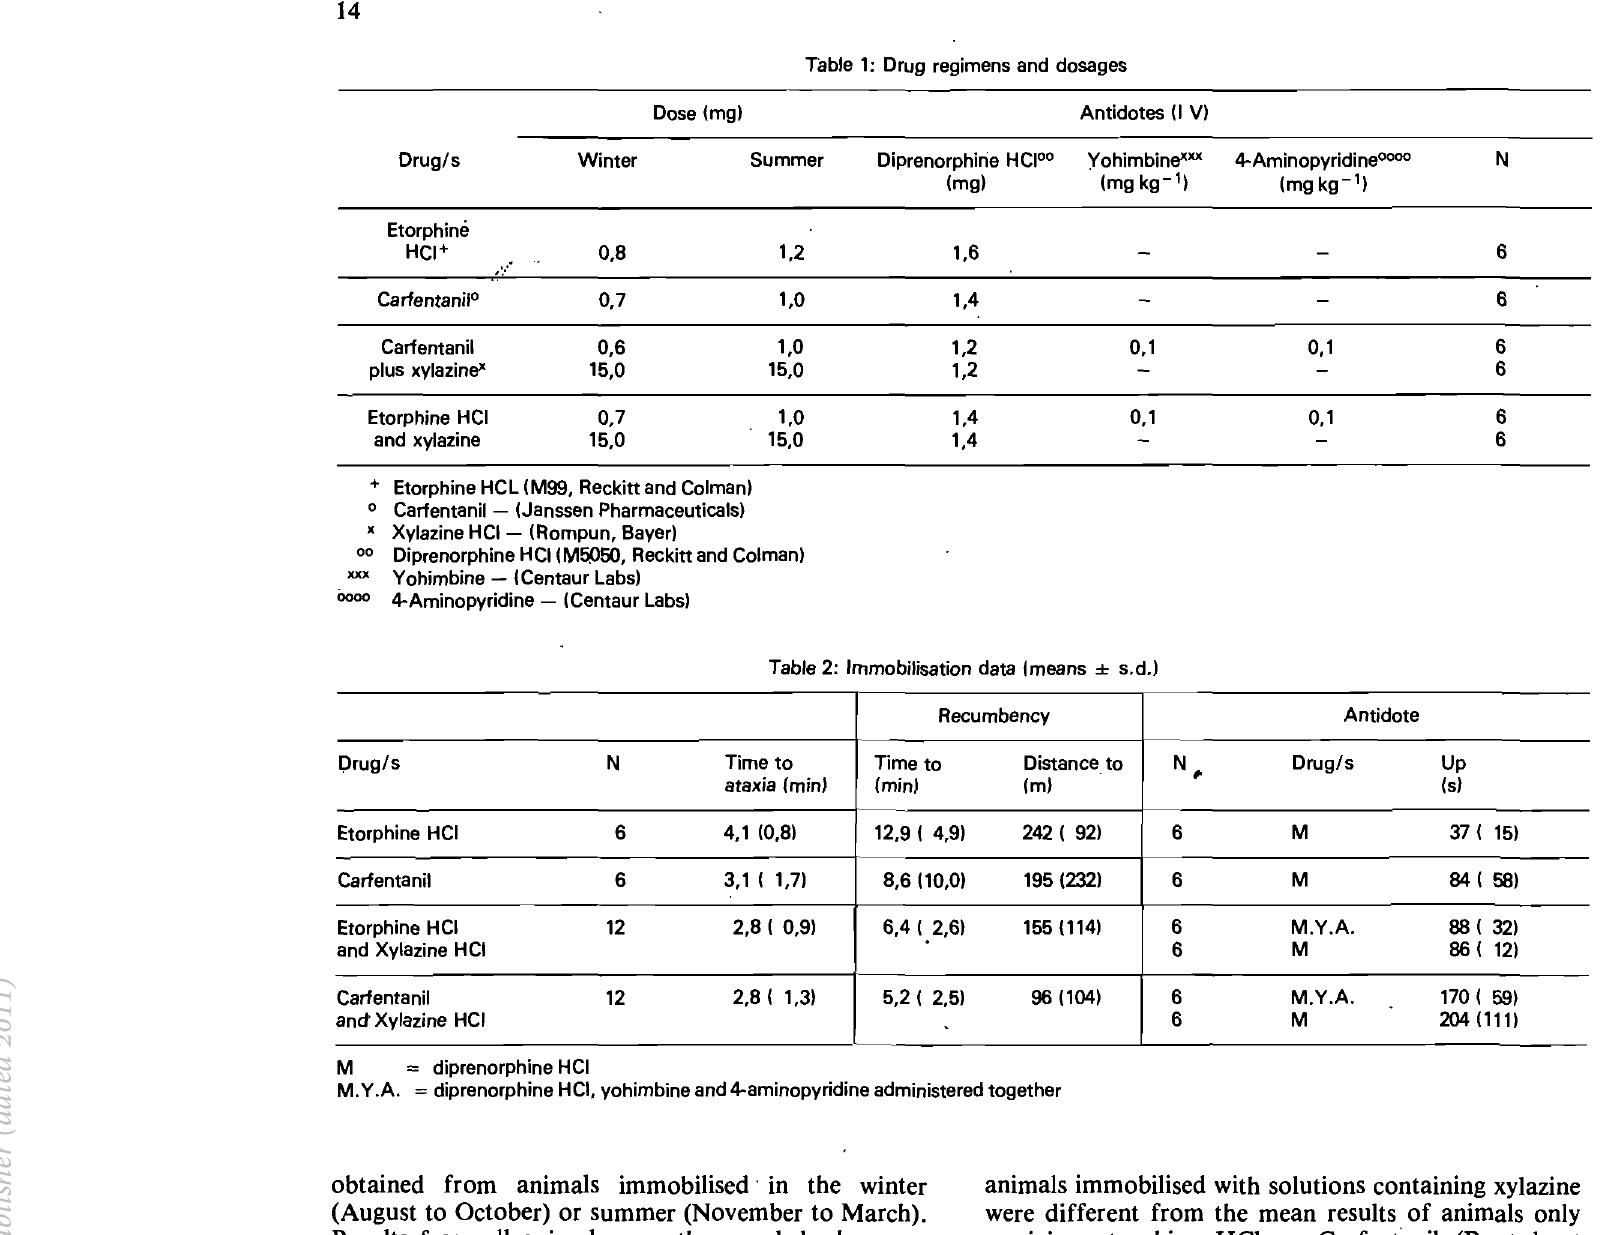
Table 2: lmmobilisation data lmeans ±